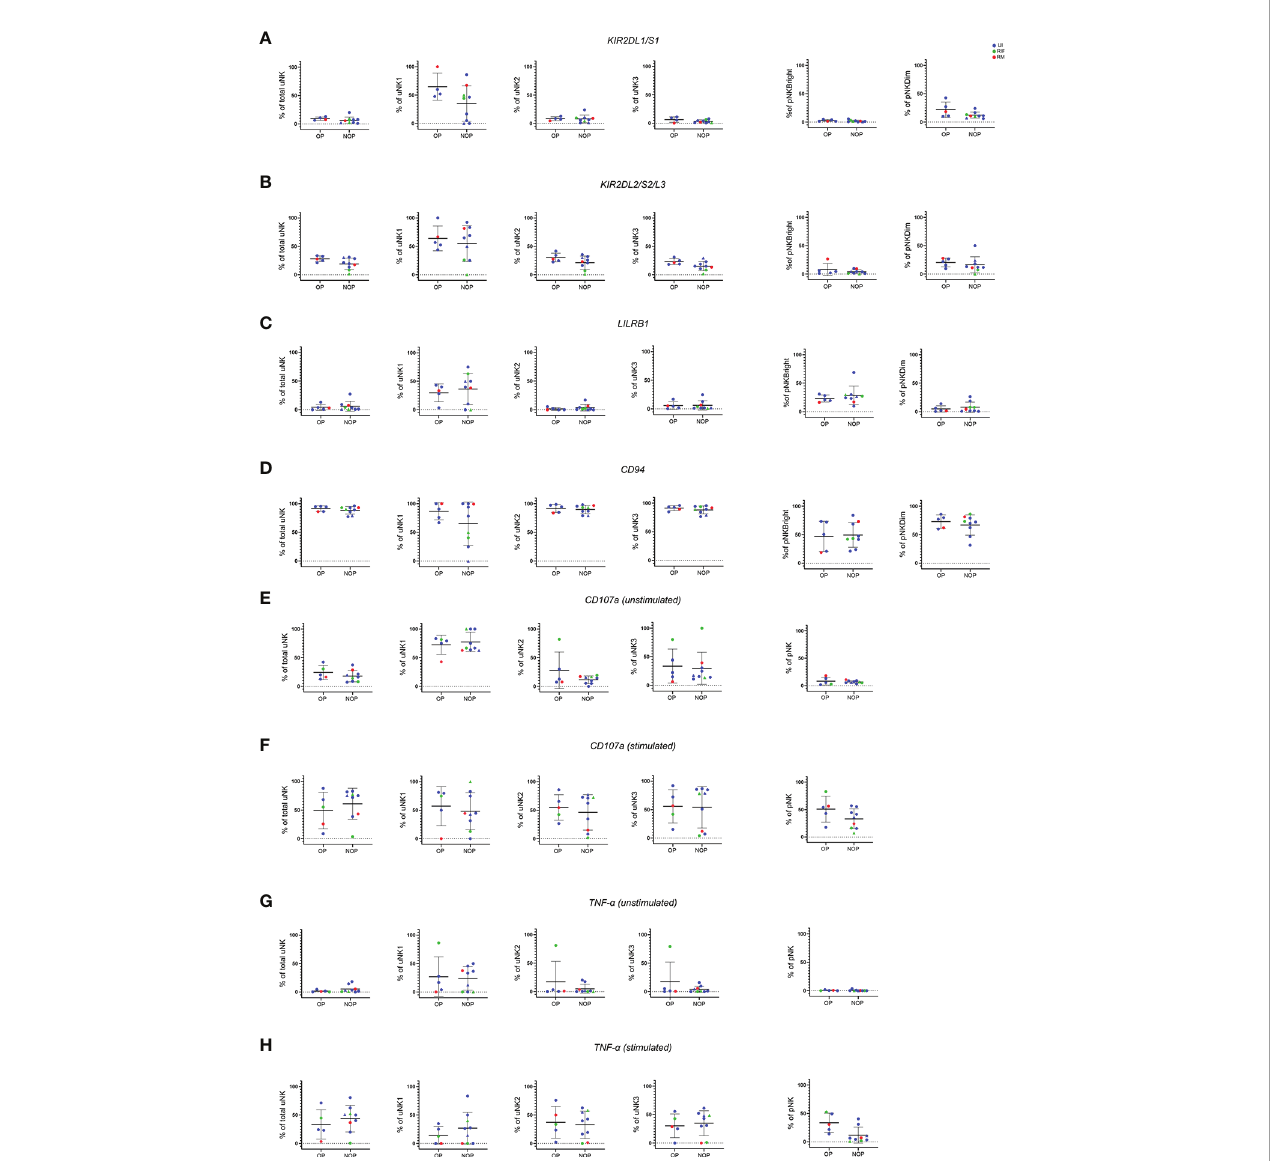
FIGURE 4 No difference in phenotype or degranulation in patients who had ongoing pregnancy compared to no ongoing pregnancy after IVF. Means and standard deviations are shown for KIR2DL1/S1 (A) , KIR2DL2/S2/L3 (B) , LILRB1 (C) , CD94 (D) , CD107a (E, F) , and TNF- a (G, H) with and without stimulation. NOP group consist of n=7 who did not become (represented as dots) and n=2 who became pregnant but miscarried (represented as triangles). Unexplained infertility (UI) is showed in blue, recurrent miscarriage (RM) is shown in red and recurrent implantation failure (RIF) is shown in green. Statistical testing was done using unpaired t-test for normal or Mann-Whitney U test for non-normal distribution and showed no signi fi cance in all of the